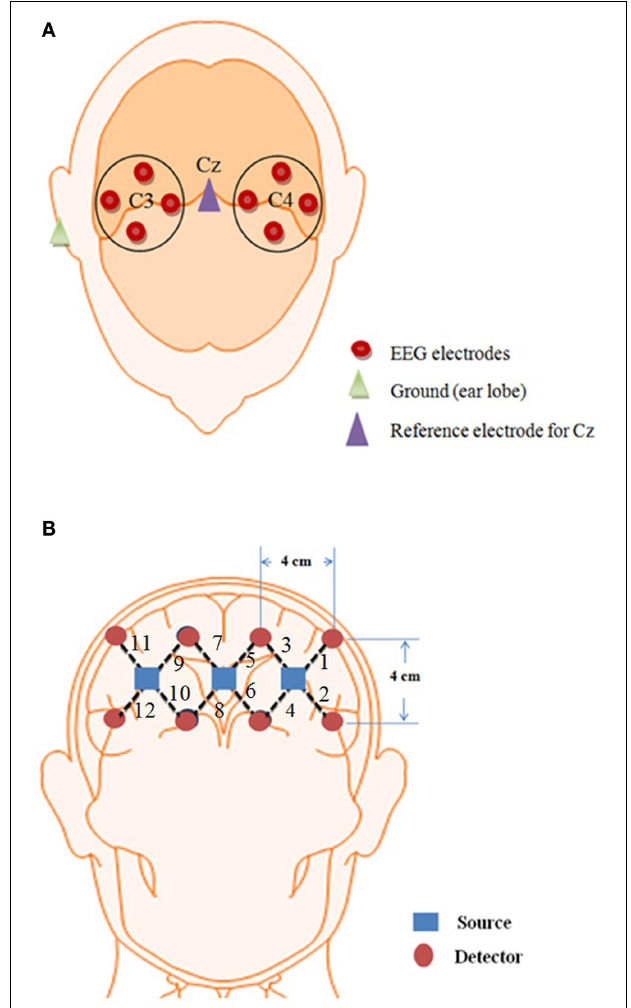
FIGURE 2 | Optode location for EEG and NIRS. (A) 8 EEG electrodes placement over the Cz of the brain, (B) 12 channel locations on the prefrontal brain region using three sources and eight